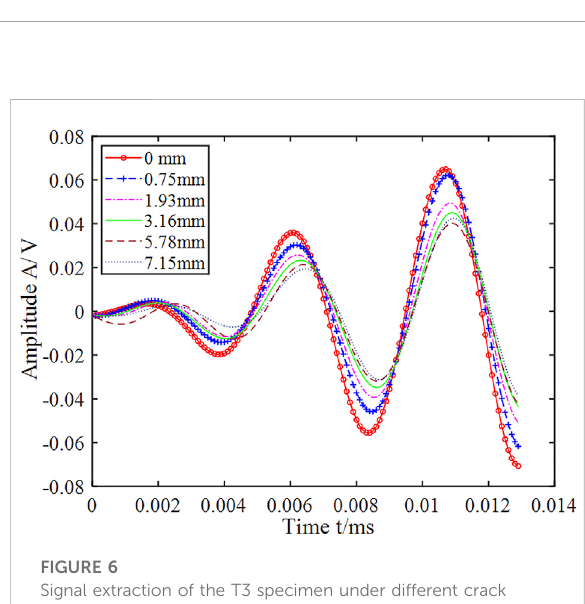
FIGURE 6 Signal extraction of the T3 specimen under different crack